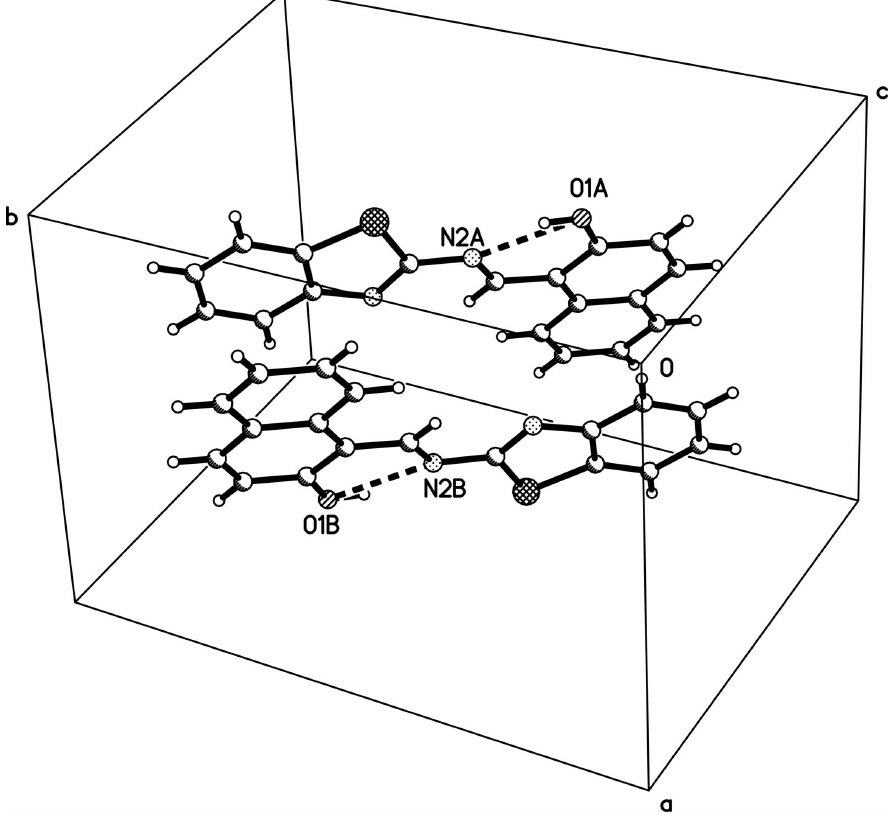
Figure 2 The crystal packing of the title compound, viewed approximately along the c